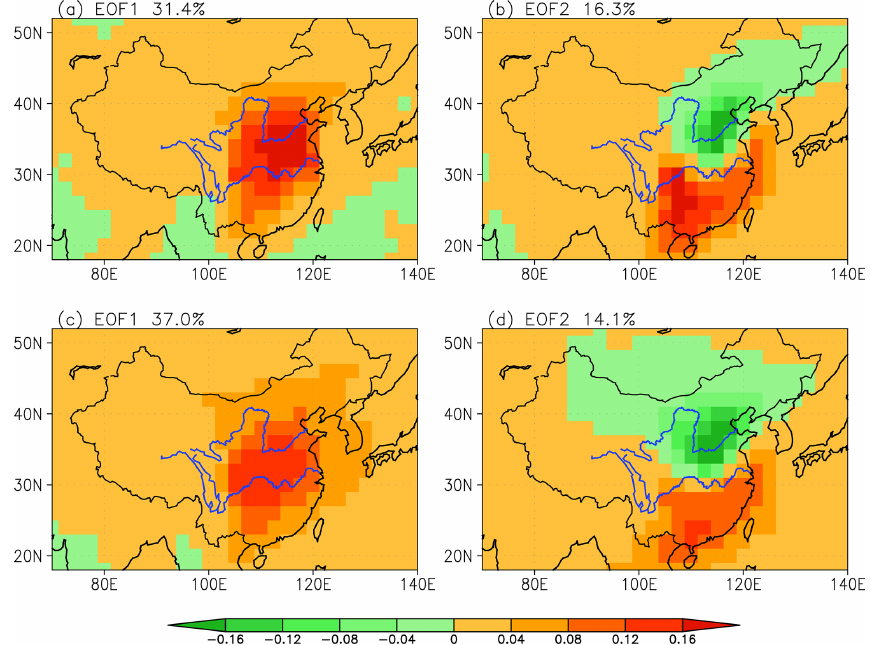
Figure 1. Spatial pattern of the (a) first empirical orthogonal function (EOF1) mode of the monthly surface PM 2 . 5 concentrations over China. (b) As in (a) but for the second mode (EOF2). (c, d) As in (a, b) but for the column concentrations. The numbers indicate fractional variance in the EOF modes.